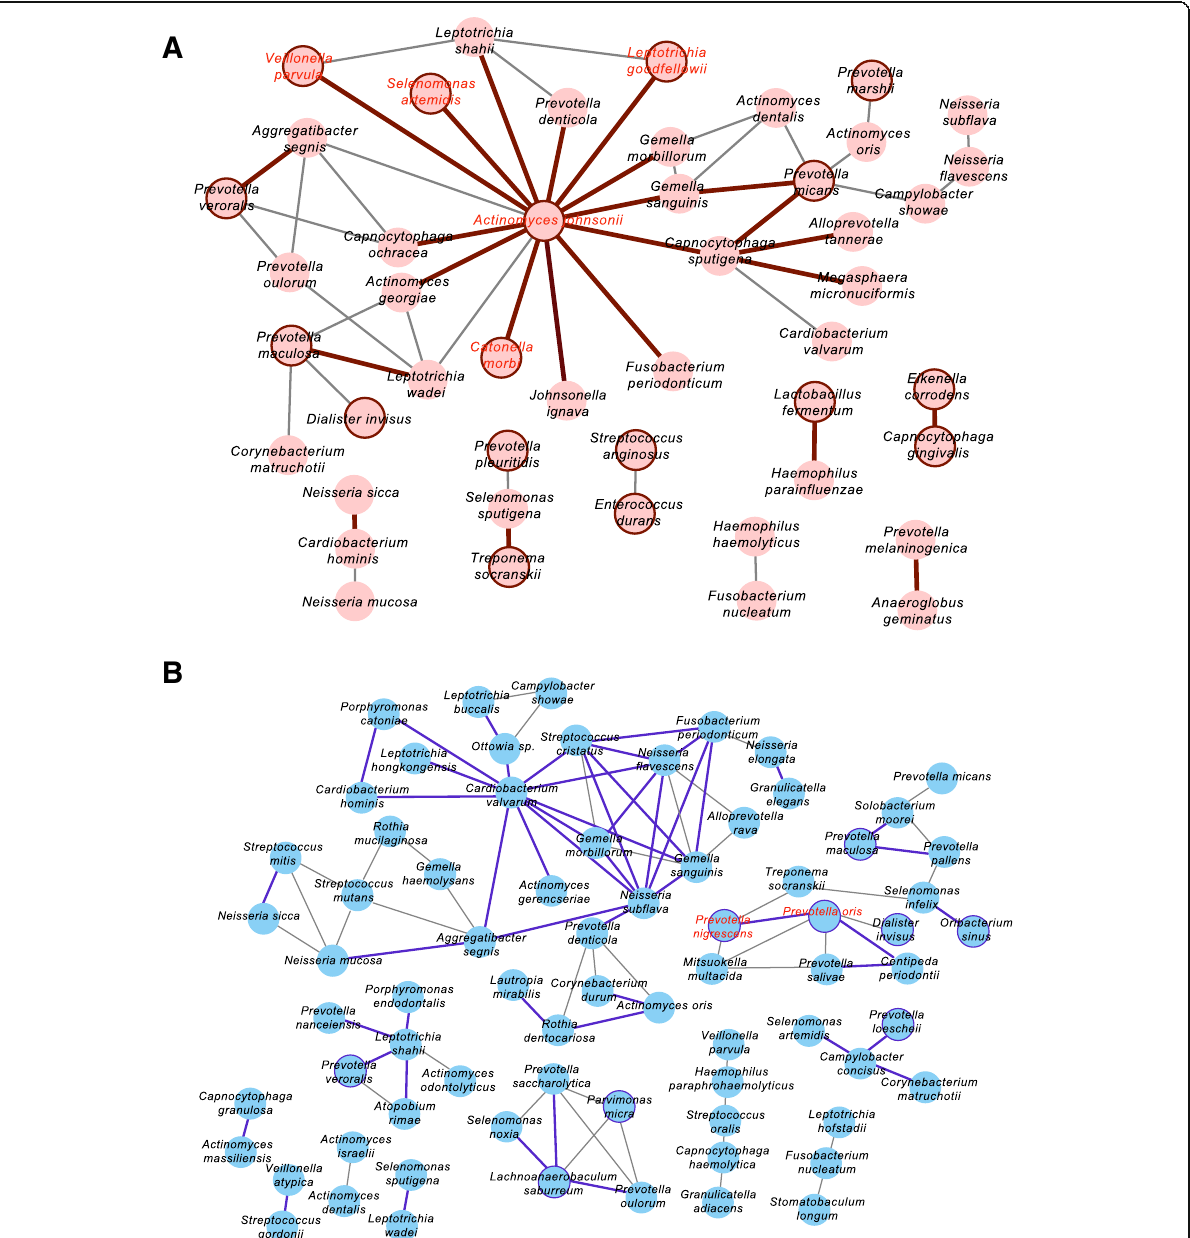
Fig. 4 Network estimated from the correlation of mRNA abundance and interacting core taxa. Two VTiF are connected if their mRNA abundances are positively correlated with a value of SparCC ≥ 0.995, for a the CLP group and b the control group. Active taxa are indicated by bold circles, and pairs of active taxa with a significant positive correlation are indicated by bold lines. Interacting core taxa (i.e., pairs of active taxa with a significant positive correlation) are indicated by red